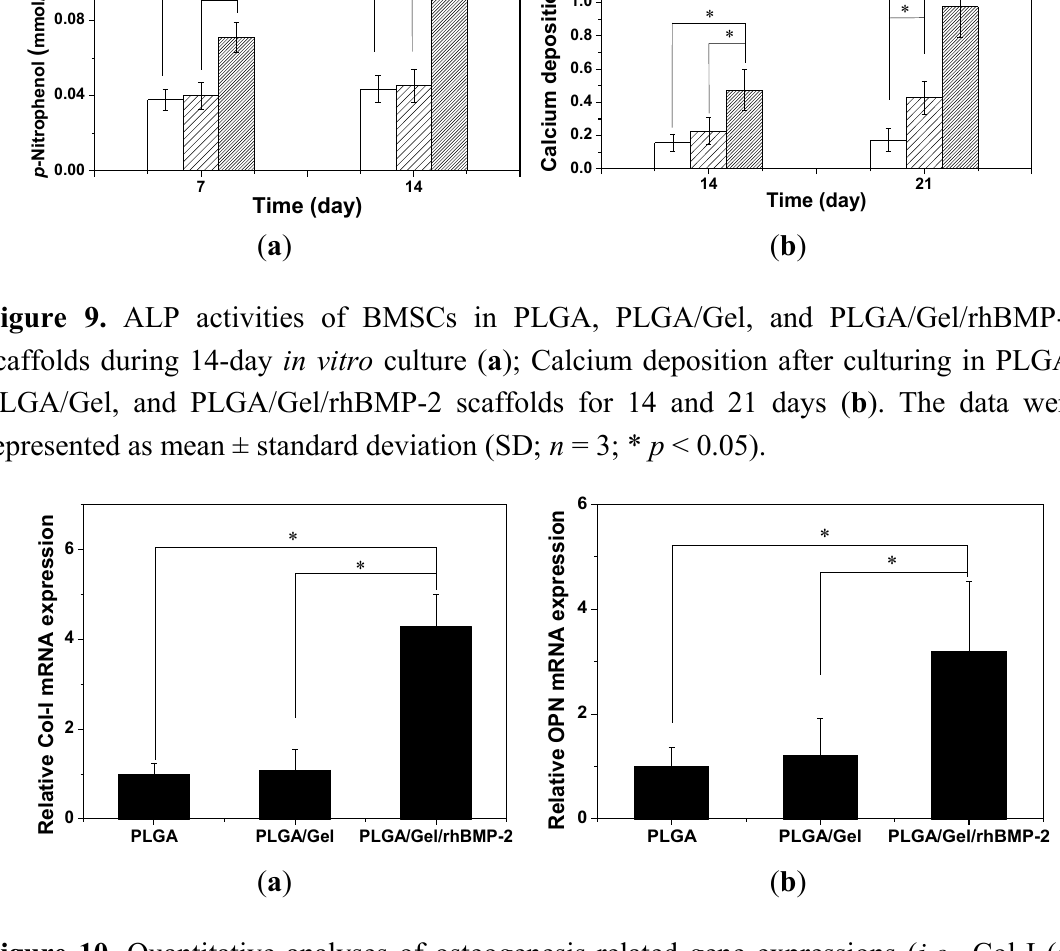
Figure 10. Quantitative analyses of osteogenesis-related gene expressions ( i.e. , Col-I ( a ) and OPN ( b )). The data were represented as mean ± standard deviation (SD; n = 3; * p <